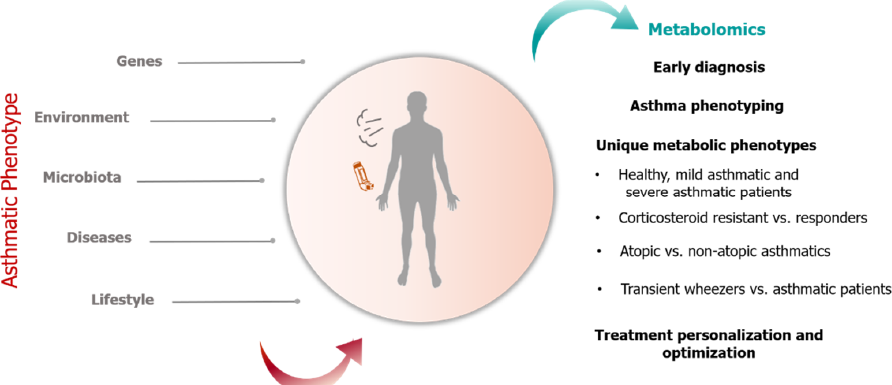
Figure 1. Genetic and non-genetic factors modulate the asthmatic phenotype which can be evaluated through metabolomics. Application of metabolomics in pediatric asthma include early diagnosis, asthma phenotyping through identification of unique metabolic fingerprints and treatment personalization and optimization.